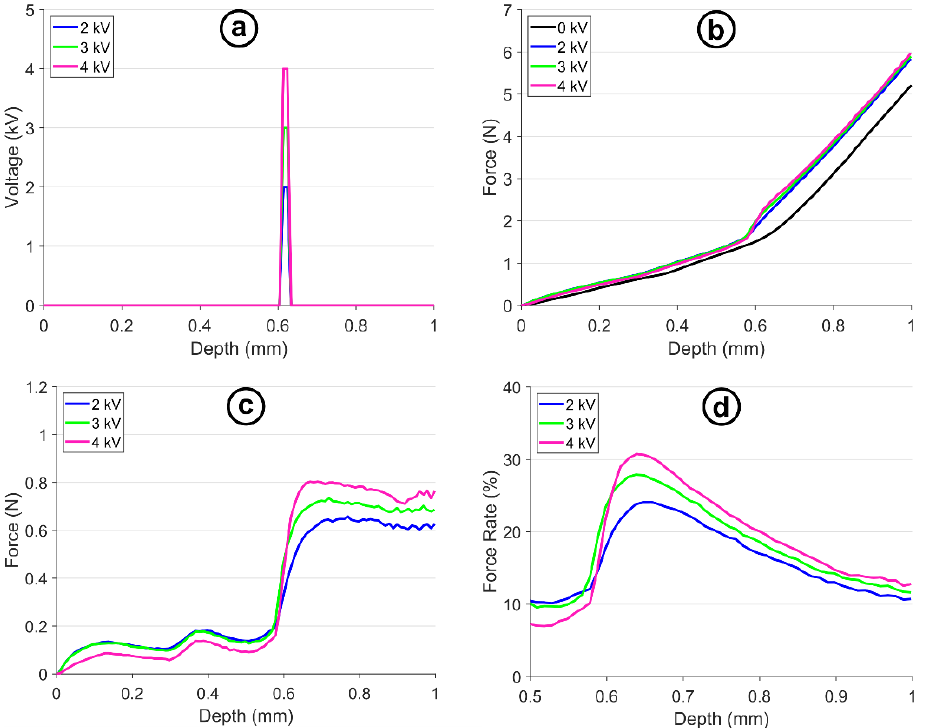
Figure 11. Results of the haptic pulse testing: ( a ) programmed voltage pulse with respect to inden- tation depth; ( b ) force – depth curve for 2, 3, and 4 kV pulses; ( c ) isolated force due to the ER effect; ( d ) force rate with respect to indentation depth focused on the effect of the pulse.